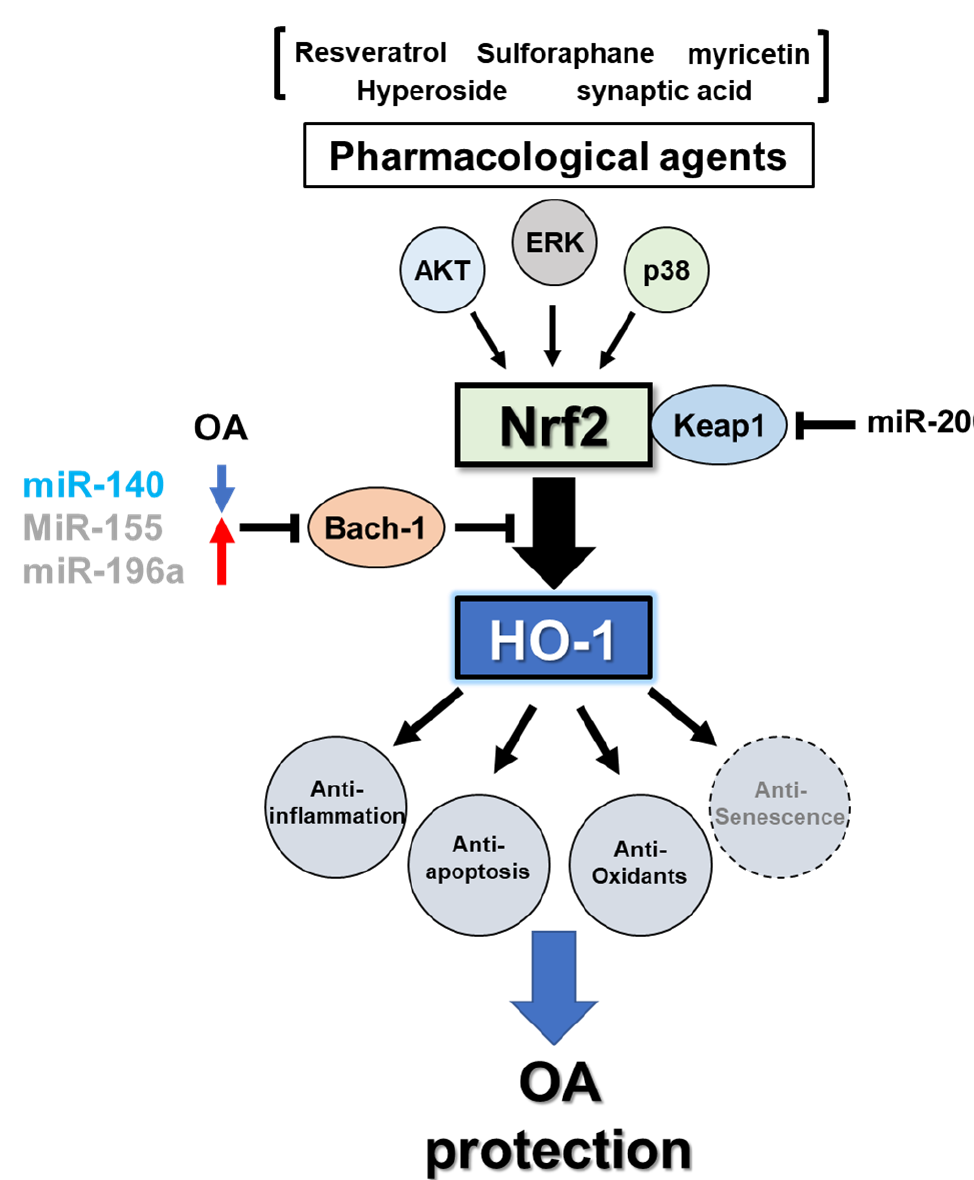
Figure 1. Schematic illustration of the osteoarthritis-protective mechanism of the Nrf2/HO-1 axis by pharmacological treatment of antioxidant signal inducers.